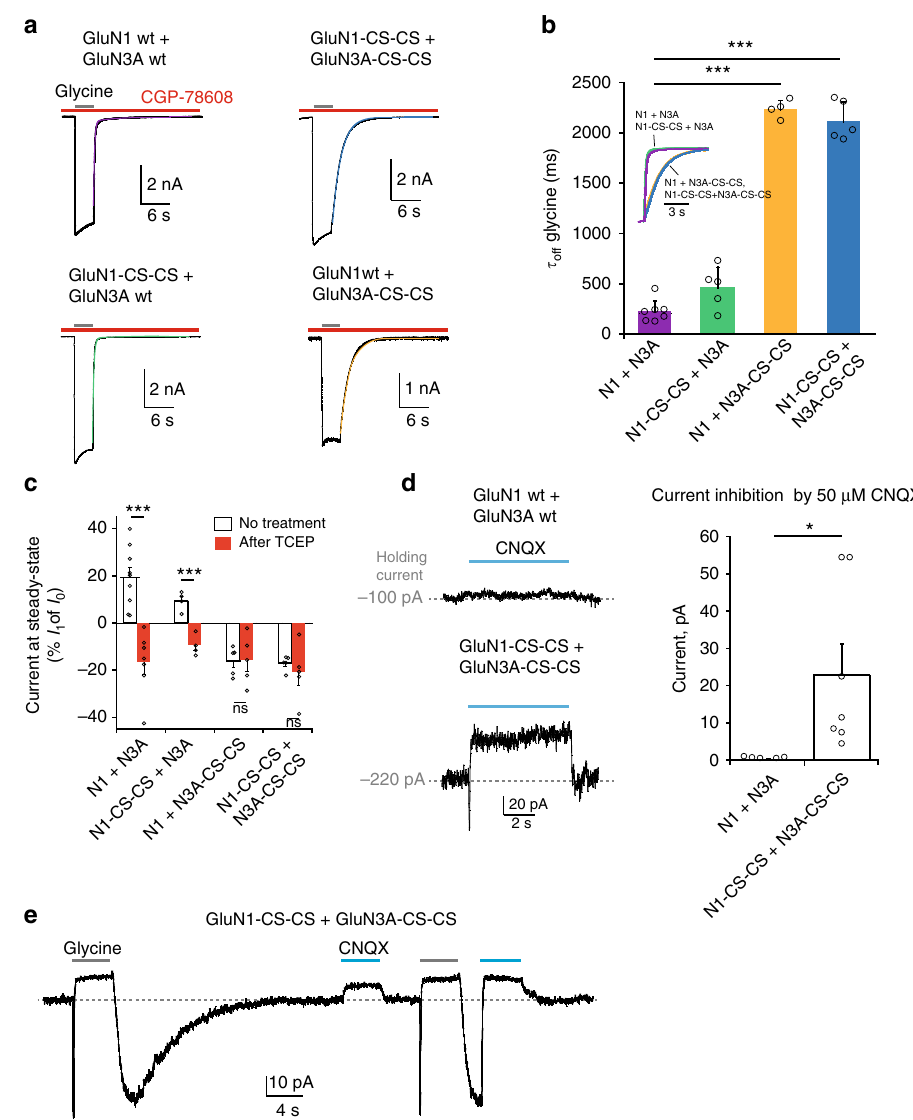
Fig. 4 High-glycine sensitivity and tonic activation of reduced GluN1/GluN3A receptors. a Glycine deactivation kinetics of wild-type and mutant receptors in presence of CGP-78608 (500 nM). Glycine was applied at 100 µ M. b Quanti fi cation of glycine deactivation kinetics. * P = 0.027, Student ’ s t -test; *** P < 0.001, Student ’ s t -test ( n = 4 – 7). Inset: representative current traces and overlaid fi ts following glycine washout. c Quanti fi cation of